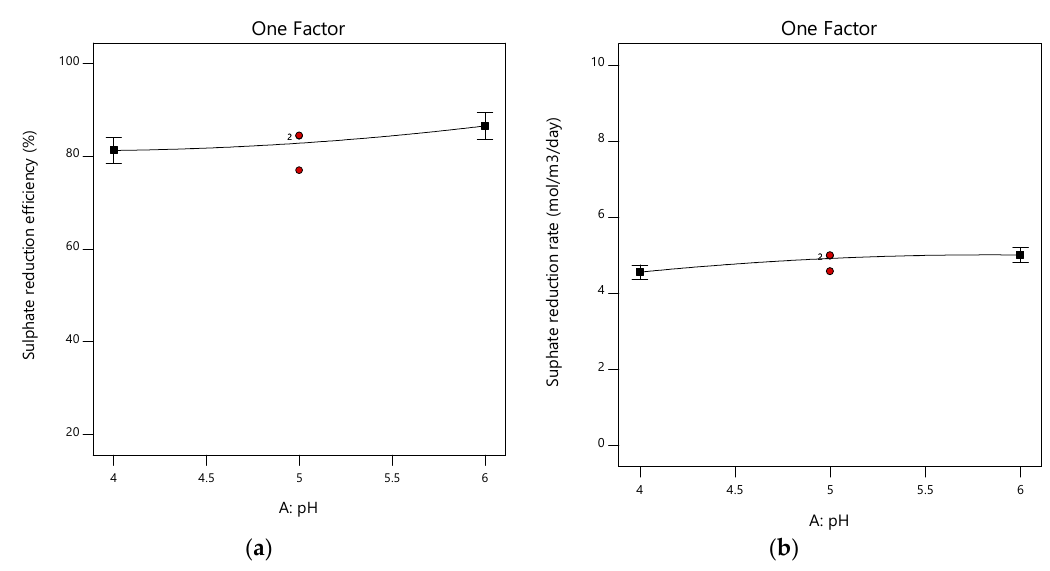
Figure 5. pH effect on ( a ) sulphate reduction efficiency and ( b ) sulphate reduction rate at 20 °C and hydraulic retention time (HRT) of 4.5 days.